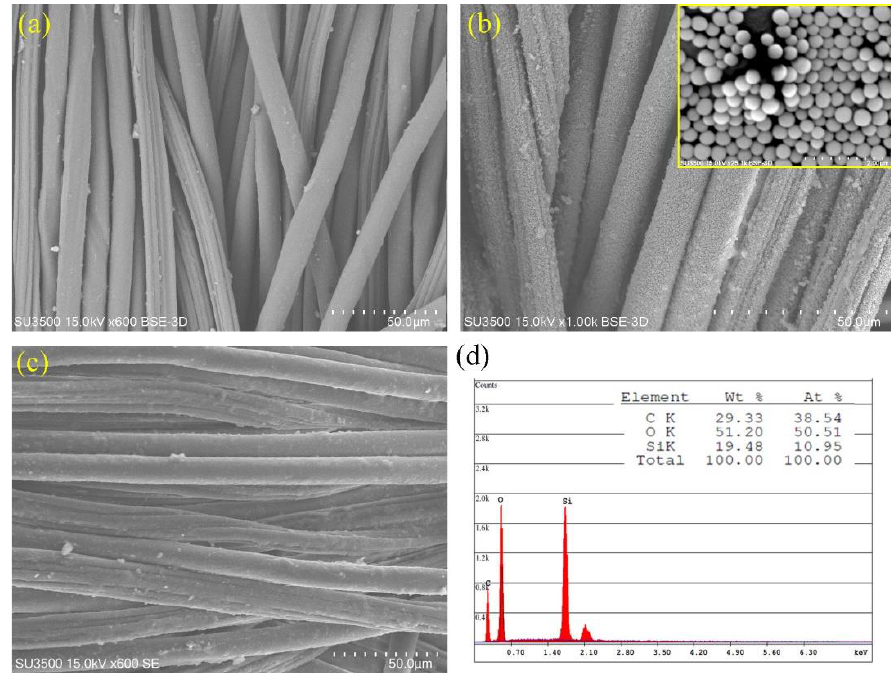
Figure 2. SEM micrographs of fabrics: ( a ) pristine, ( b ) silica-coated, ( c ) PDMS-APTES treated, and ( d ) EDS pattern of superhydrophobic fabric.